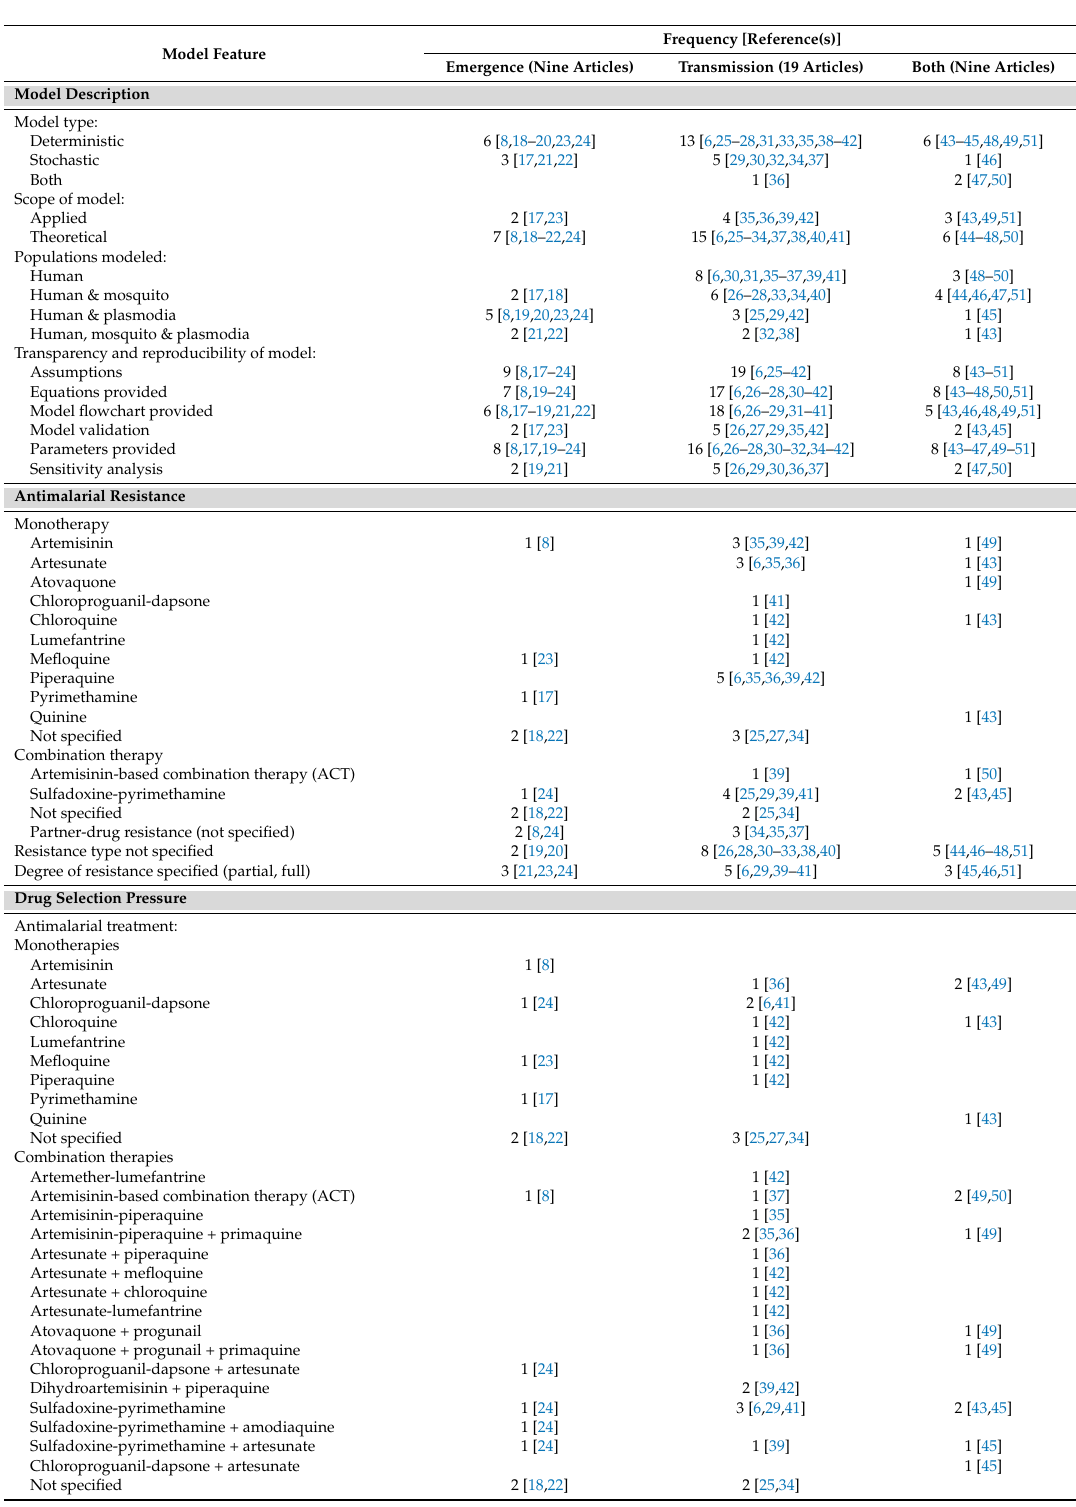
Table 1. A summary of the model